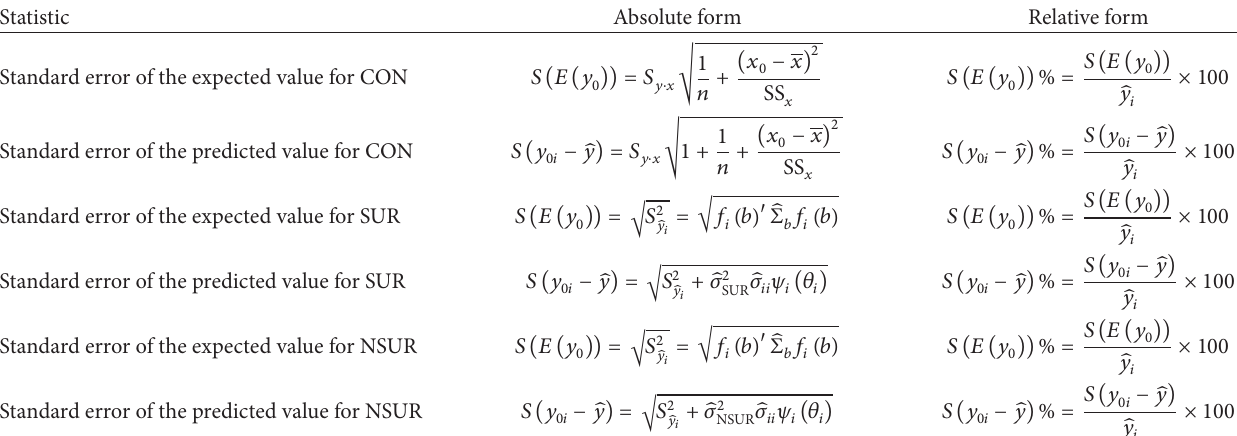
Table 4: Standard error of the expected and predicted values for different